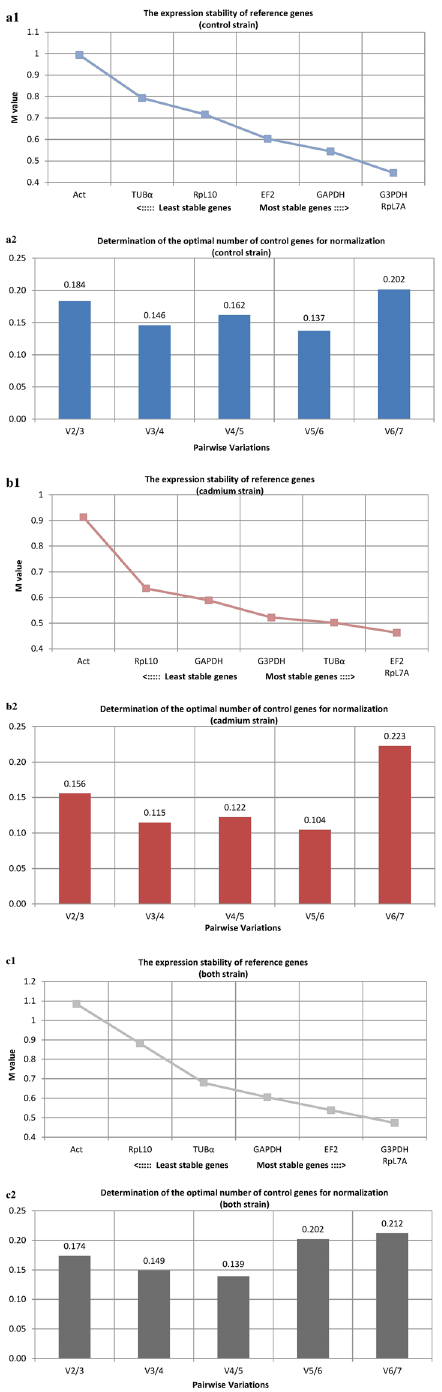
Figure 3. Expression stability of 7 candidate reference genes as calculated by geNorm software to check expression stability ( a1,b1,c1 ) and indicate the optimum number of reference genes required for qPCR data normalization ( a2,b2,c2 ). Abbreviations: (a) control strain, (b) cadmium strain, (c) both strain (all samples), GAPDH – glyceraldehyde 3-phosphate dehydrogenase, G3PDH – glycerol-3-phosphate dehydrogenase, EF2 – elongation factor 2, RpL7A – ribosomal protein L7A, RpL10 – ribosomal protein L10, TUB α – alpha tubulin, ACT – cytoplasmic actin